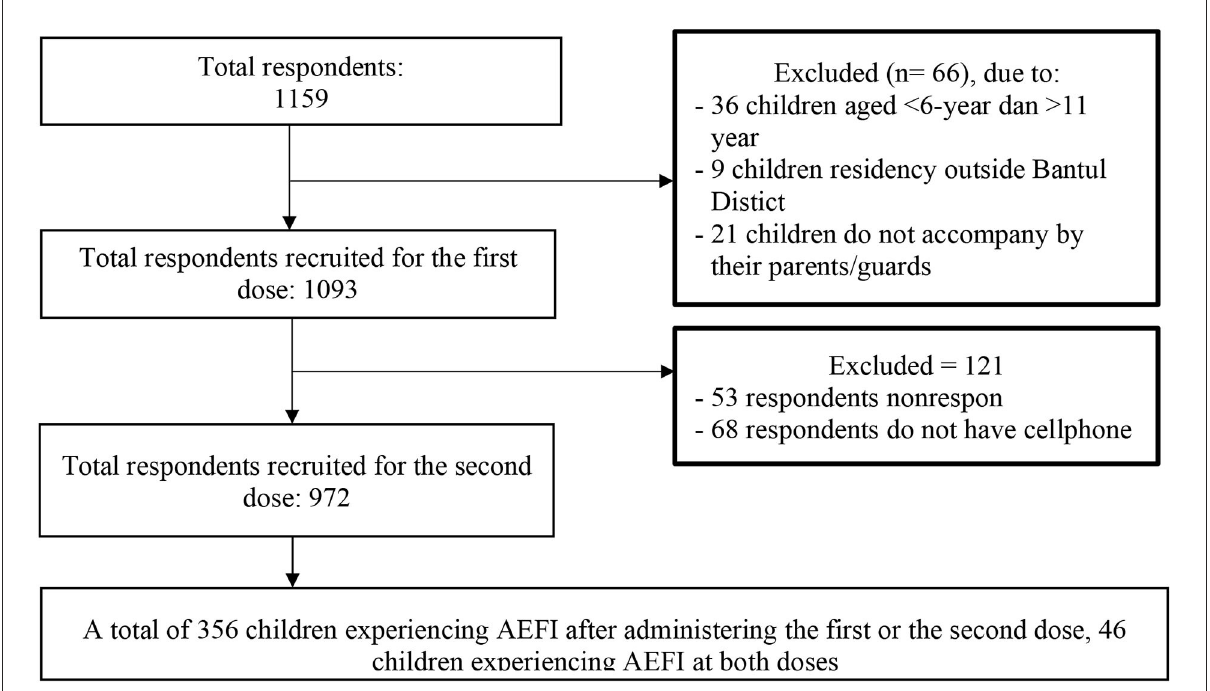
FIGURE1 Respondents recruitment